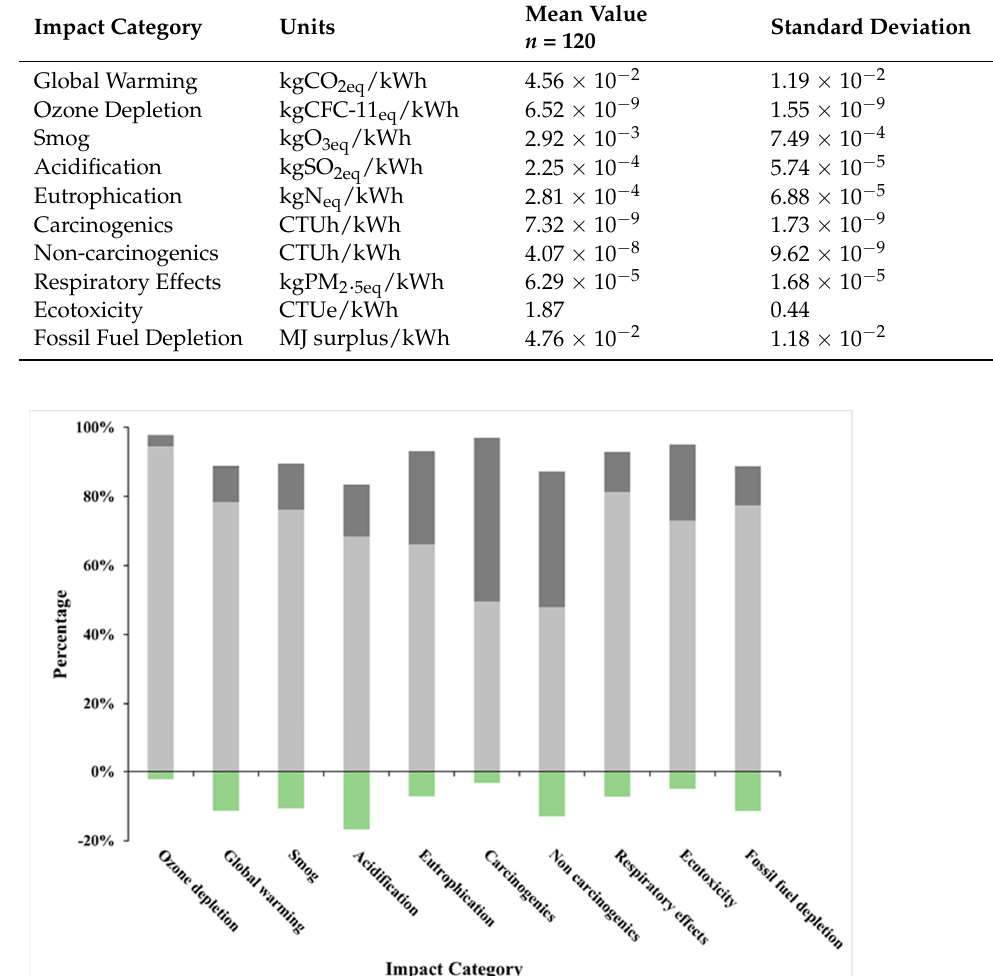
Table 3. Environmental profile of 1 kWh of electricity generation from 120 solar photovoltaic systems in NYS based on a cradle-to-grave life cycle analysis.